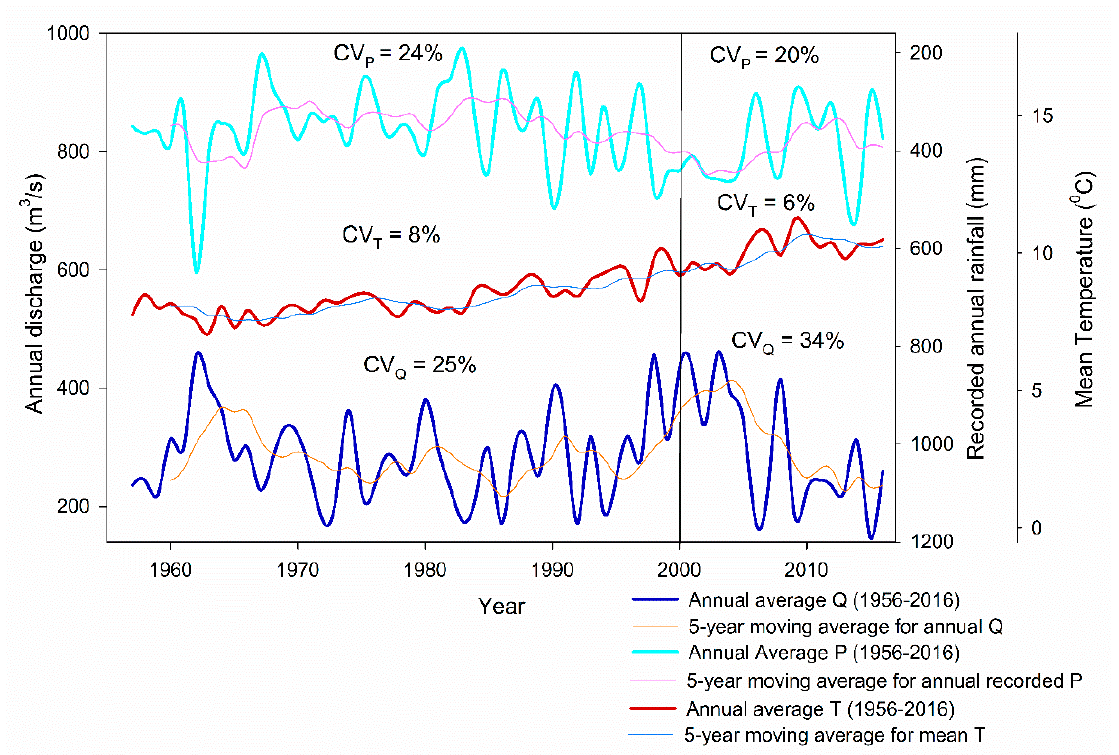
Figure 5. Changes of annual river discharge (at the Lhasa hydrometric station), annual mean temperature, and annual recorded precipitation for the Lhasa River Basin from 1956 to 1999 and from 2000 to 2016 (study time period with reservoirs functioning in the study area).